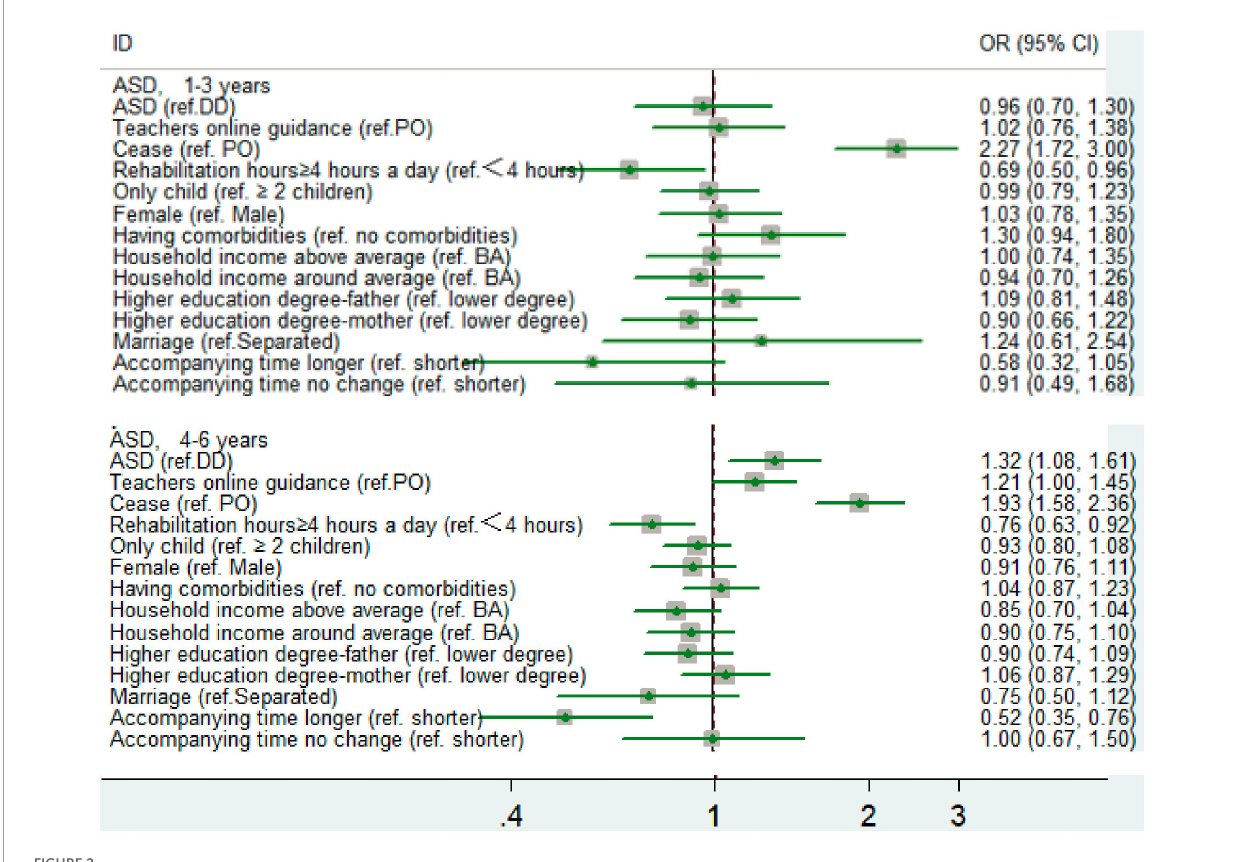
of negative emotional and behavioral changes occurring was lower (OR 0.40; 95% CI 0.29–0.55 for families where time spent did not change and OR 0.35; 95% CI 0.26–0.48 for families where time spent was longer than previously; see Table 4